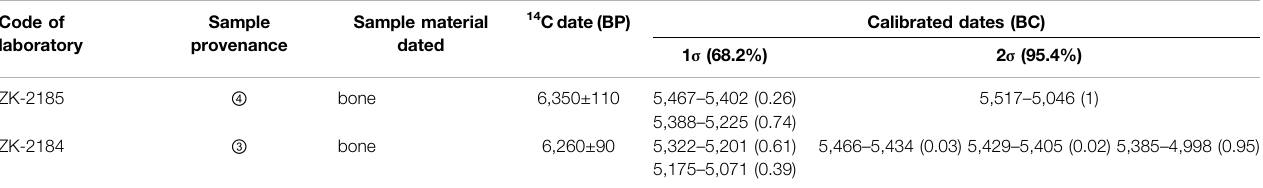
TABLE 1 | Carbon-14 dates and dendrochronologically corrected dates of bone samples excavated at